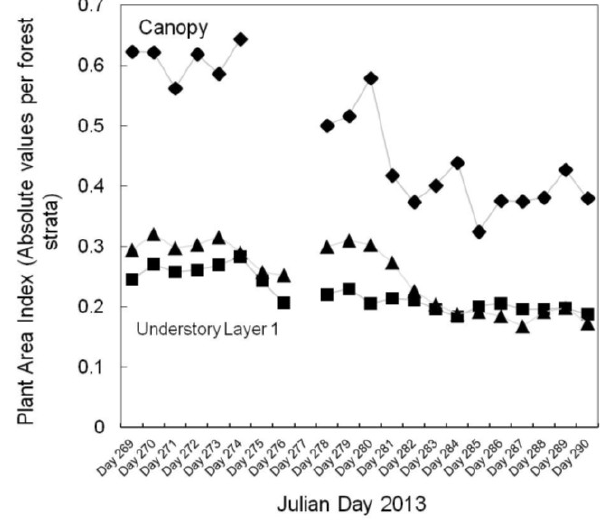
Figure 6. Time-series of Total Plant Area Index (PAI) values calculated by the VEGNET IML during September 26 and October 17, 2013 for the understory, subcanopy (understory layer 2), and Canopy